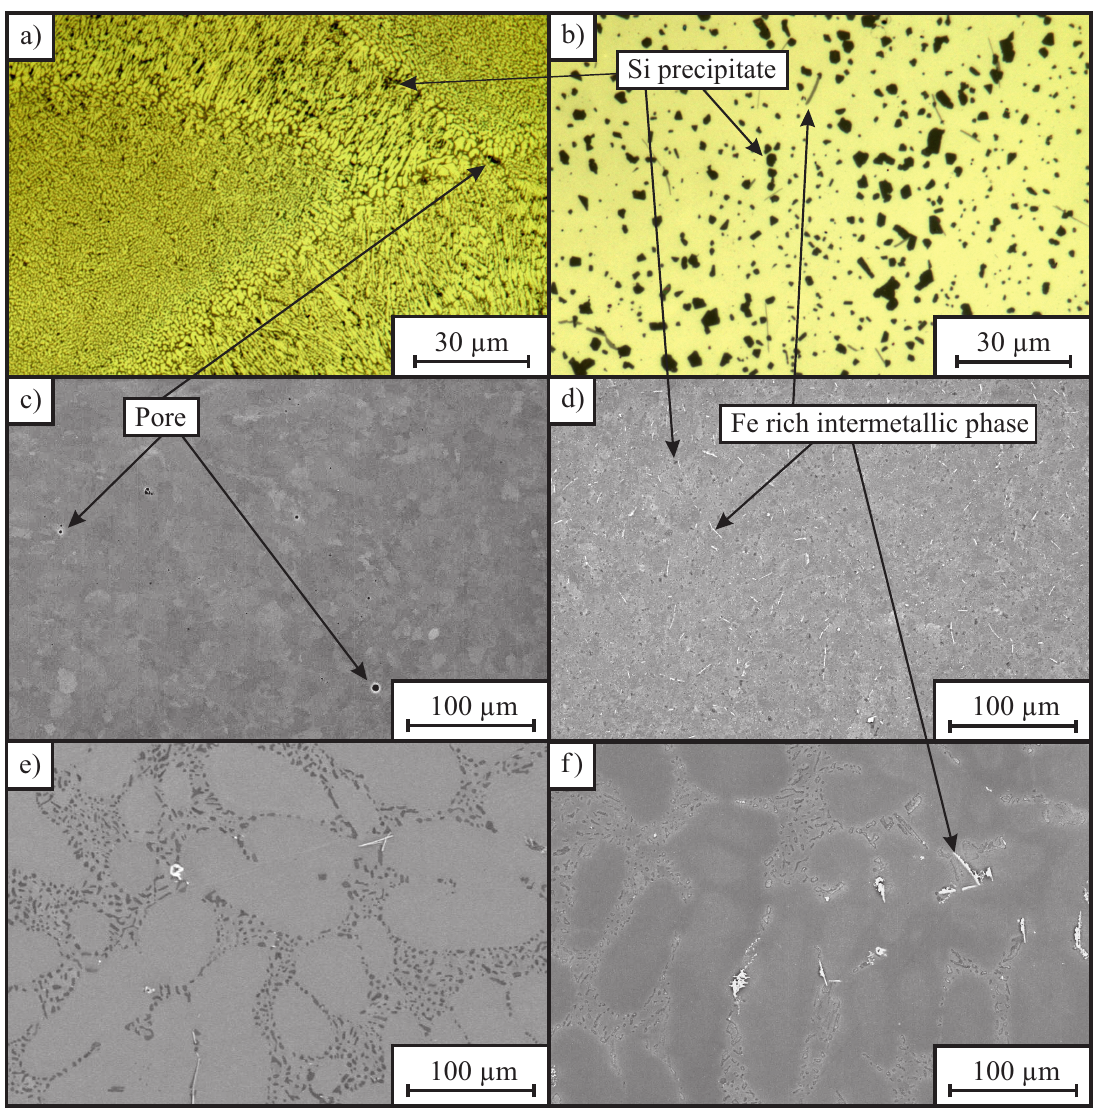
Figure 3. Micrographs of the alloys; ( a ) image of the laser powder-bed fusion (L-PBF) alloy AlSi10Mg0.3 in as-built condition obtained with an optical microscope; ( b ) image of the L-PBF alloy AlSi10Mg0.3 in hot isostatically pressed and direct-aged condition obtained with an optical microscope; ( c ) scanning electron image of the L-PBF alloy AlSi10Mg0.3 in as-built condition; ( d ) scanning electron image of the L-PBF alloy AlSi10Mg0.3 in hot isostatically pressed and direct-aged condition; ( e ) scanning electron image of the sand-cast alloy AlSi7Mg0.3 in as-cast condition, ( f ) scanning electron image of the sand-cast alloy AlSi7Mg0.3 in hot isostatically pressed and direct-aged